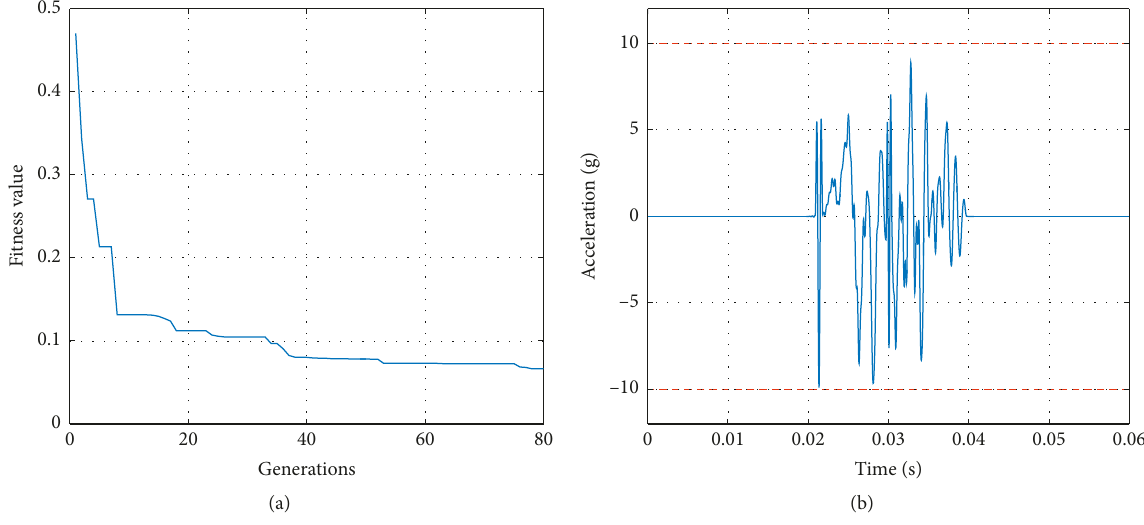
Figure 7: Fitness curve and synthesized TSW. (a) Evolutionary process; (b) shock